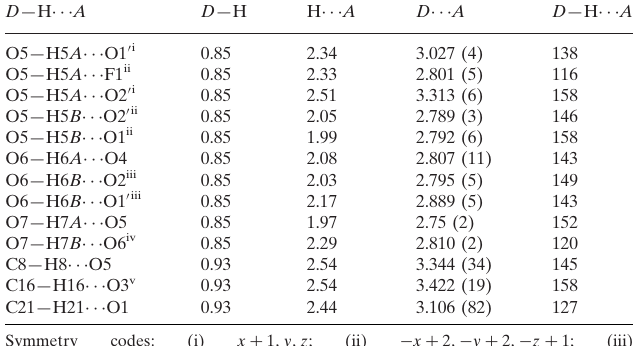
Hydrogen-bond geometry (A˚ , (cid:3)